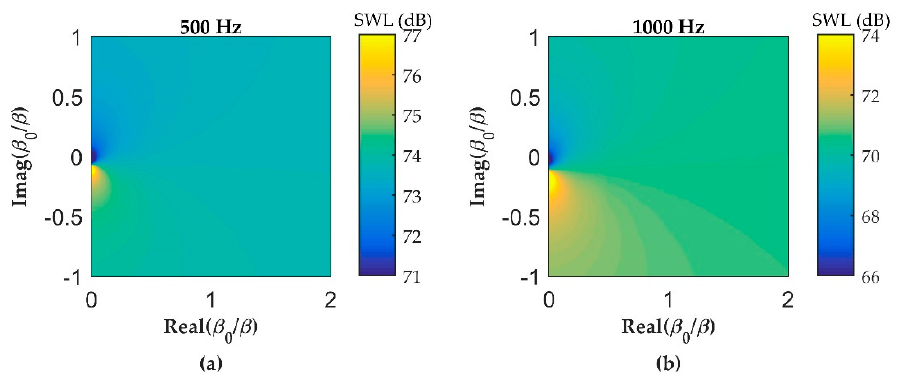
Figure 3. The sound power level (SWL) flowing from Σ 2 to Space III varies with the top edge impedance at ( a ) 500 Hz; ( b ) 1000 Hz.